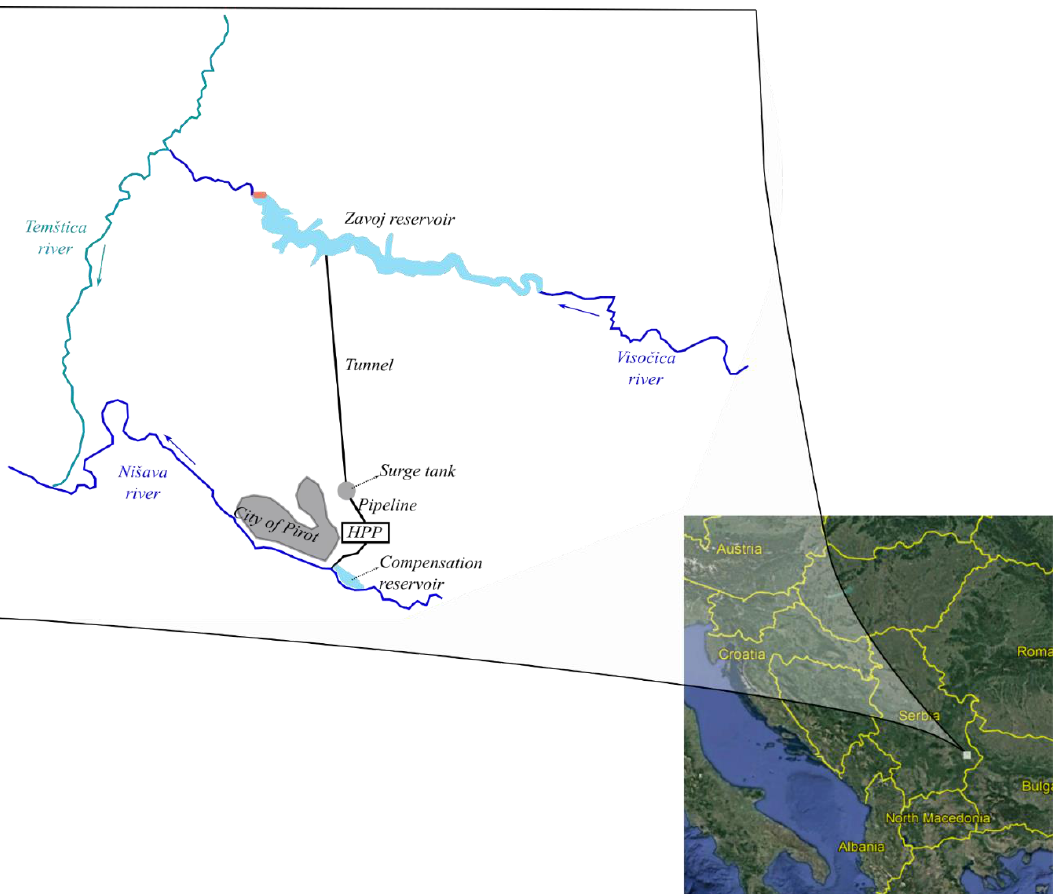
Figure 4. Schematic representation of the Pirot DRS.